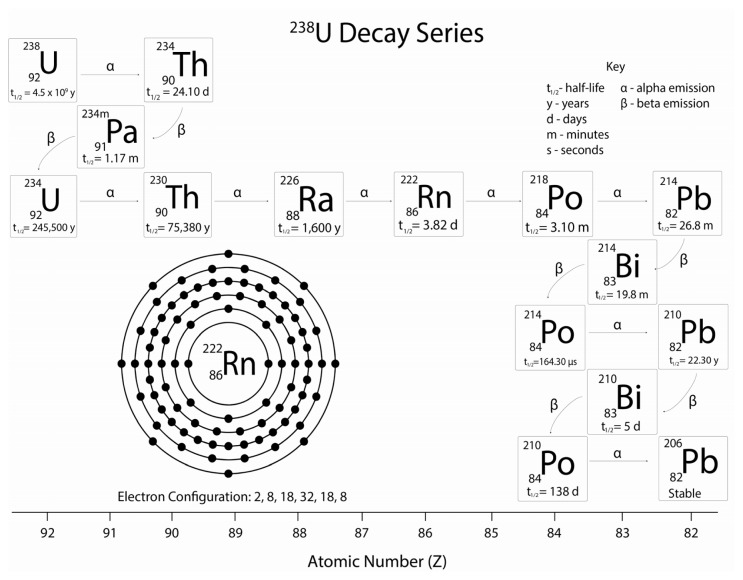
The decay series of uranium-238 indicating its decay products, their half-lives and the electron configuration of radon-222 complete with each respective atomic number.